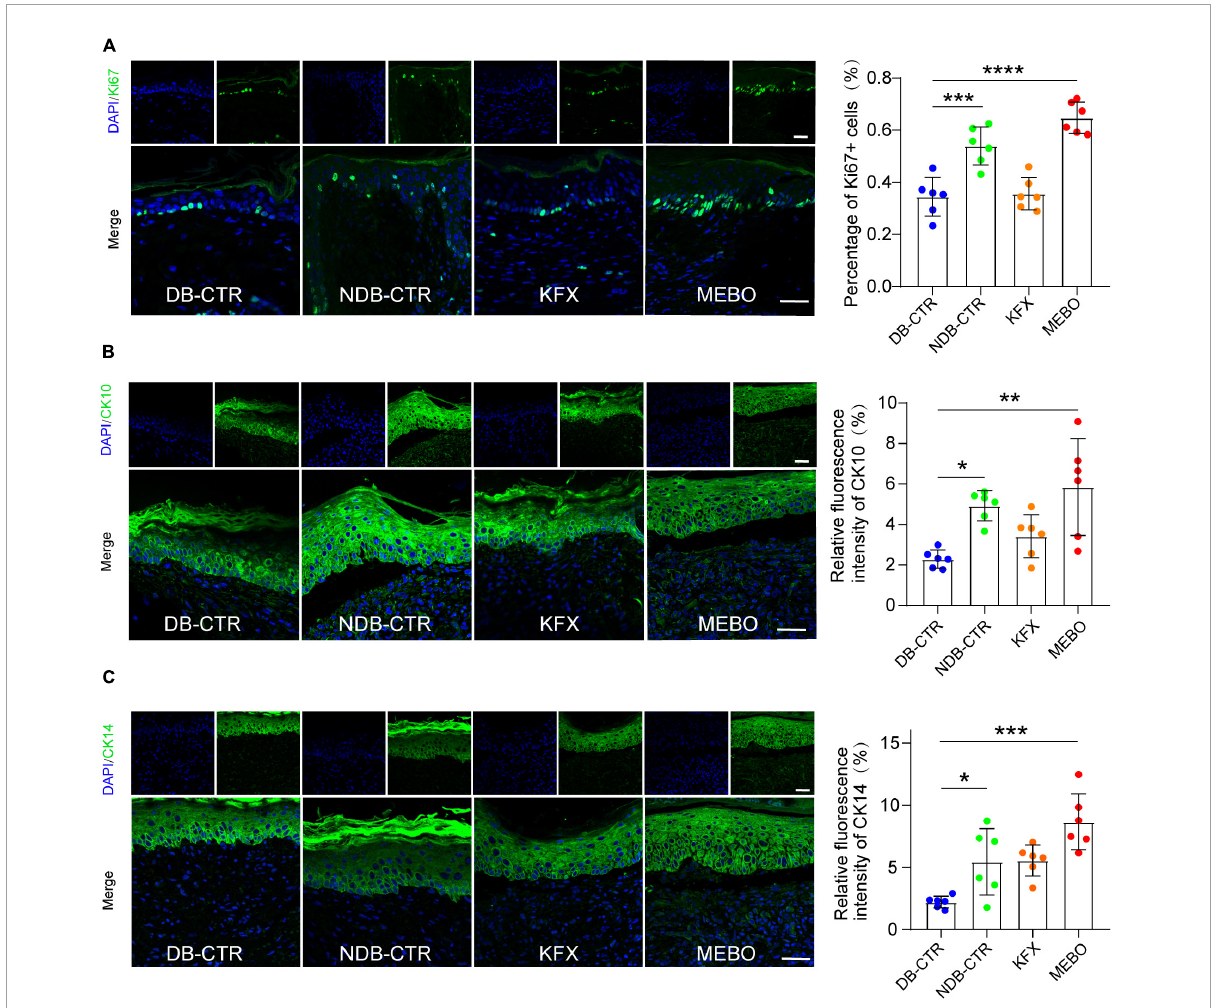
FIGURE4 MEBO promoted re-epithelialization in the process of diabetic wound healing. (A) The representative immunofluorescence images of regenerated skin tissue of mice in each group were taken by a confocal microscope, the green was Ki67, DAPI, and the nucleus were blue. The percentage of Ki67-positive basal layer cells in the regenerated epidermis of mice in each group was statistically analyzed by ImageJ software. (B) The representative immunofluorescence images of regenerated skin tissue of mice in each group were taken by a confocal microscope, the green was CK10, DAPI, and the nucleus were blue. The percentage of CK10-positive cells in the regenerated epidermis of mice in each group was statistically analyzed by ImageJ software. (C) The representative immunofluorescence images of regenerated skin tissue of mice in each group were taken by a confocal microscope, the green was CK14, DAPI, and the nucleus were blue. The percentage of CK14-positive cells in the regenerated epidermis of mice in each group was statistically analyzed by ImageJ software. The scale was 50 µ m. At least 6 independent sections were chosen at each time for each group. All Data are shown as mean i ± SD, * P < 0.05, ** P < 0.01, *** P < 0.001, **** P <